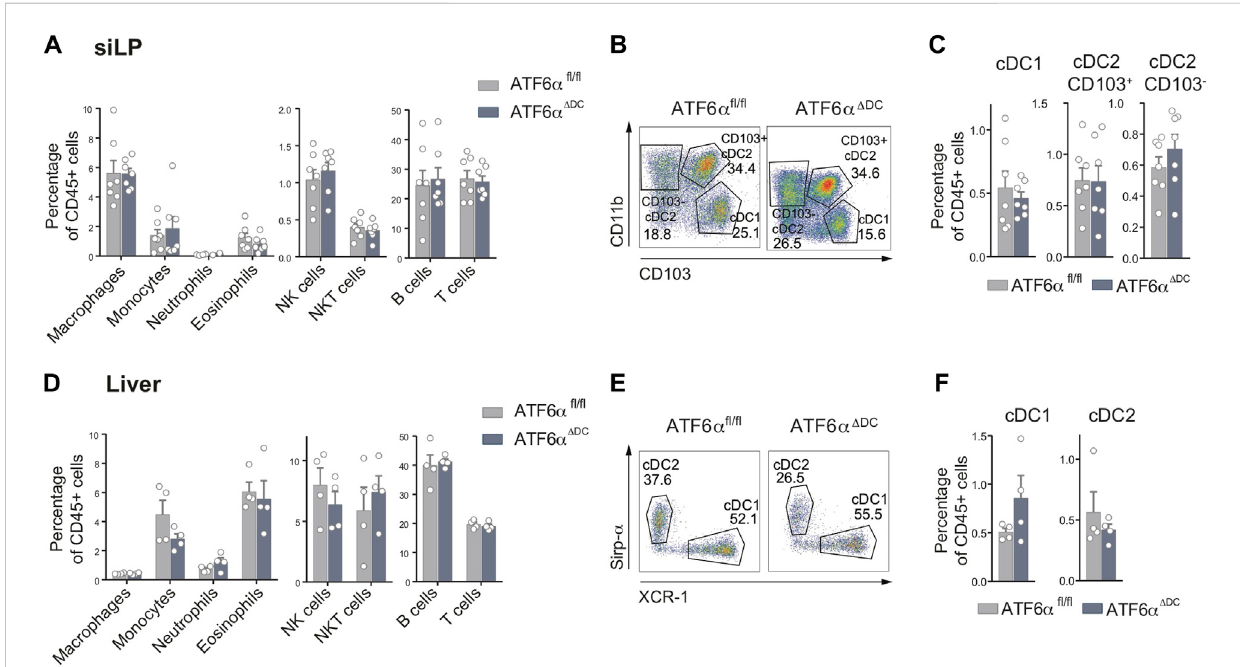
FIGURE 2 Normal cDC composition in small intestinelamina propria and liver of ATF6 α -de fi cient mice. (A) Percentage of immune cells relativeto CD45 + cells from SiLP of ATF6 α fl / fl ( n = 7 mice) and ATF6 α Δ DC mice ( n = 7 mice). Bar graph depicts mean percentage of cells (±s.e.m.). Each symbol represents one sample obtained from 3 independent experiments. (B) Representative fl ow cytometry plots showing distribution of cDC1s and cDC2 subsets in SiLP of ATF6 α fl / fl and ATF6 α Δ DC mice. Cells were pre-gated as single live CD45 + , CD64 − , F4/80 − , B220 − , CD3 − , LY6G − , NK1.1 − , Ly6C − /int , CD11b + , CD11c + , MHC-II + . (C) PercentageofcDC1sandcDC2srelativetoCD45 + cellsfromSiLPofATF6 α fl / fl ( n =7mice)andATF6 α Δ DC mice( n =7mice).Bargraphdepicts mean percentage of cells (±s.e.m.). Each symbol represents one sample obtained from 3 independent experiments. (D) Percentage of immune cells relative to CD45 + cells from liver of ATF6 α fl / fl ( n = 7 mice) and ATF6 α Δ DC mice ( n = 7 mice). Bar graph depicts mean percentage of cells (±s.e.m.). Each symbol represents one sample obtained from 3 independent experiments. (E) Representative fl ow cytometry plots showing distribution of cDC1s and cDC2s in liver of ATF6 fl / fl and ATF6 Δ DC mice. Cells were pre-gated as single live CD45 + , CD64 − , F4/80 − , B220 − , CD3 − , LY6G − , NK1.1 − , Ly6C − /int , CD11b + , CD11c + ,MHC-II + . (F) PercentageofcDC1sandcDC2srelativetoCD45 + cellsfromliverofATF6 α fl / fl ( n =7mice)andATF6 α Δ DC mice( n =7mice).Bargraph depicts mean percentage of cells (±s.e.m.). Each symbol represents one sample obtained from 3 independent experiments. For statistical analyses in (A,C,D, and F) , non-parametric Mann-Whitney test was